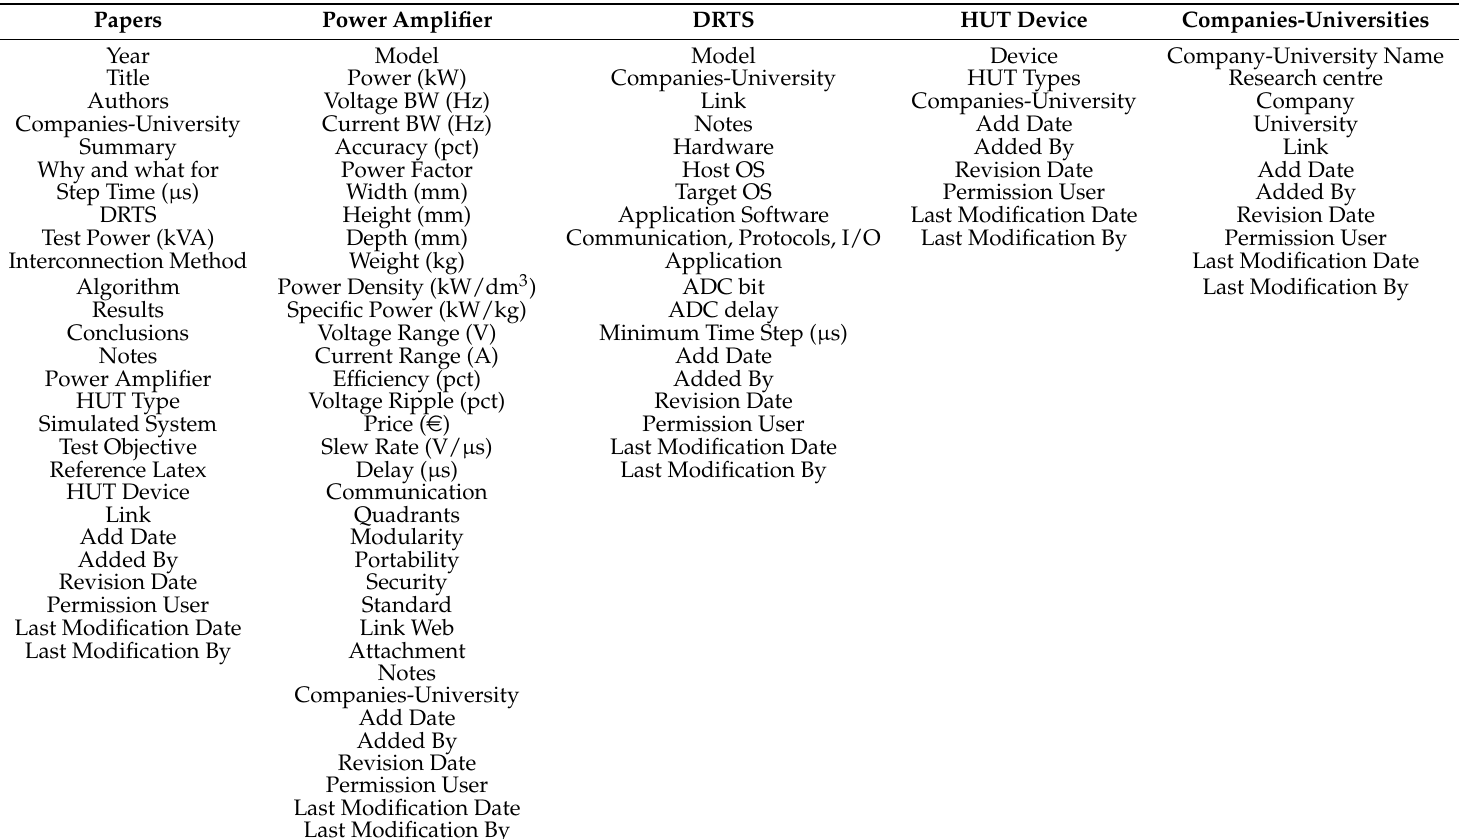
Table 2. Fields of the different tables database designed to help in the PHIL system selection process, and to facilitate the PHIL tests reproducibility